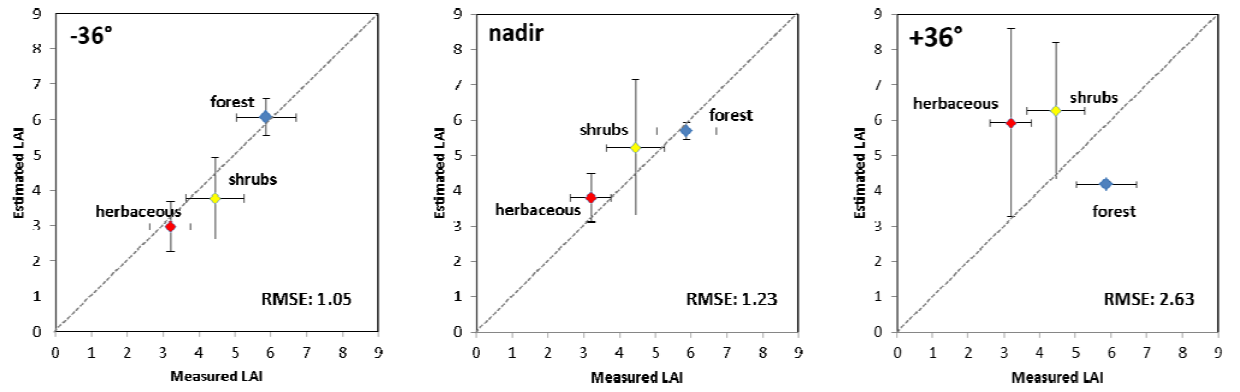
Figure 5. Mean validation results and standard deviation of the estimated LAI obtained with FLIGHT model inversion, plotted against the measured LAI values obtained with the hemispherical camera for the backward scattering direction ( − 36° VZA), the nadir direction and the forward scattering direction (+36°